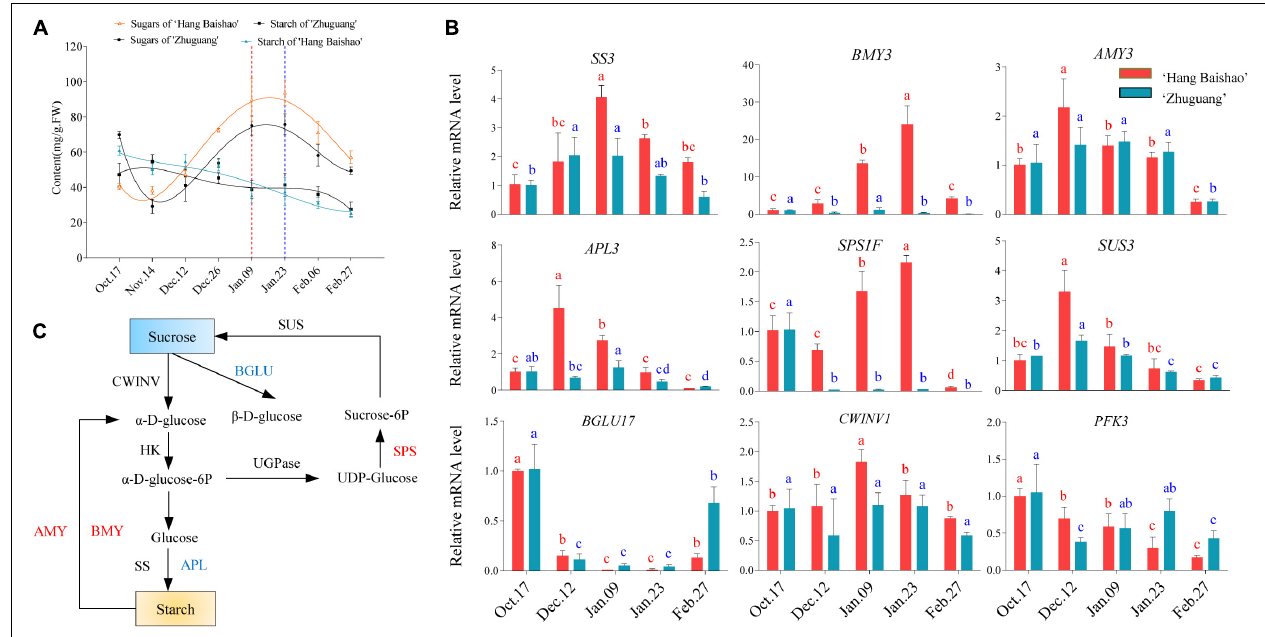
X The morphological data were non-existent because only partial plants sprouted finally due to insufficient chill accumulation. APH and APW, the average plant height and width, respectively; ANS, the average number of mature and normal stems; WFS, the number of weeks until the first plant sprouted in the glasshouse; WAS, the number of weeks until all plants sprouted in the glasshouse. H represents ‘Hang Baishao’ and Z represents ‘Zhuguang.’ All values are means ± standard deviation, different letters indicate significant differences (P < 0.05). Differences were compared among different move dates for each cultivar.